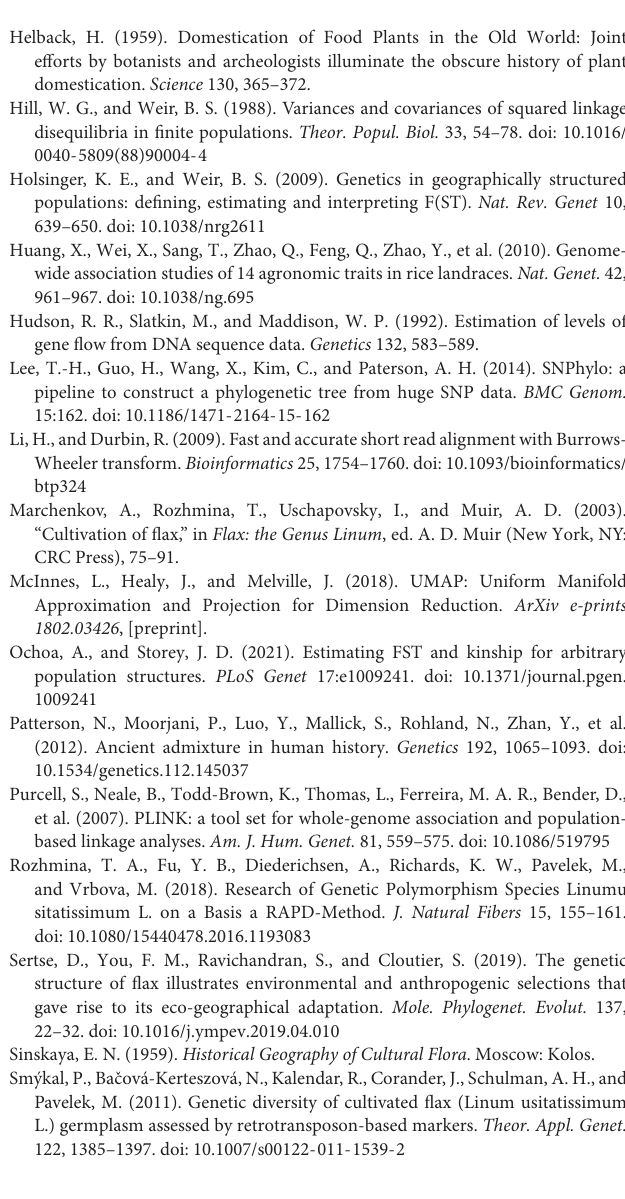
Supplementary Figure 3 | A maximal likelihood phylogenetic tree constructed from genome-wide SNPs. The outermost ring depicts distribution of accession in accordance with UMAP-derived groups. Supplementary Figure 4 | A heatmap representation of kinship coefficients calculated between accession pairs. The coefficient values are shown in the shades of blue. Side panels show breeding status and morphotype for each accession. Supplementary Figure 5 | Kinship graphs constructed for flax accessions broken down by selection status and colored by morphotype. Nodes are accessions, while edges represent first-degree relations (pi_hat > 0.5). Edge thickness reflects pairwise pi_hat values. (A) Kryazhs, (B) landraces, and (C) breeding lines and